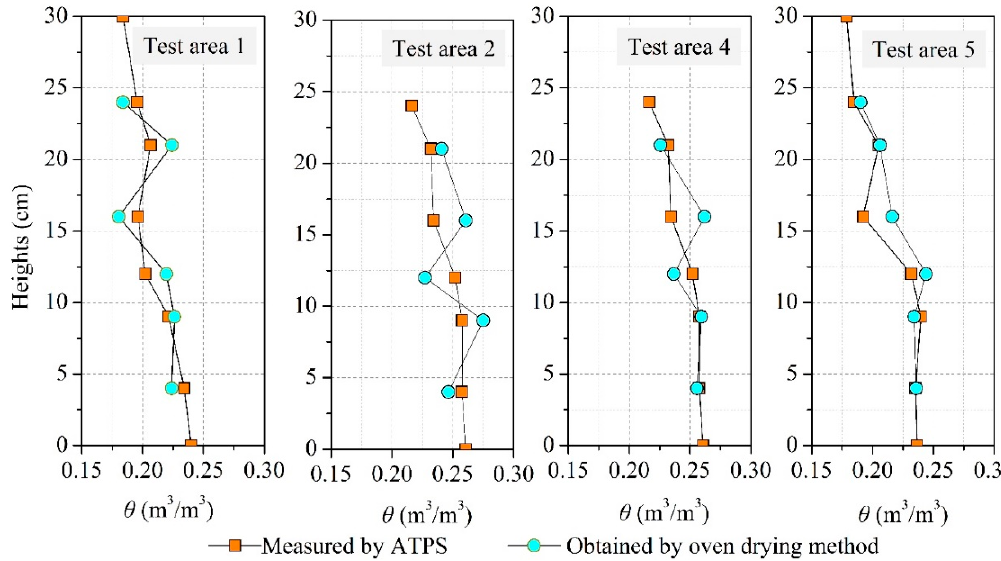
Figure 11. Soil moisture profiles measured 18 h after rainfall by two methods.